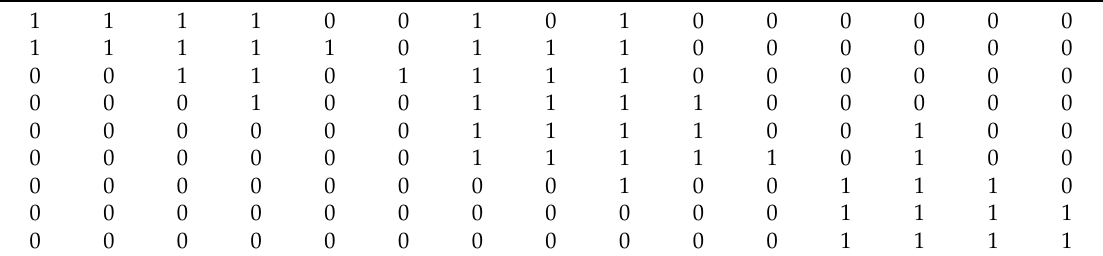
Table A1. Artificial data set with 15 species (columns) and 9 sites (rows).